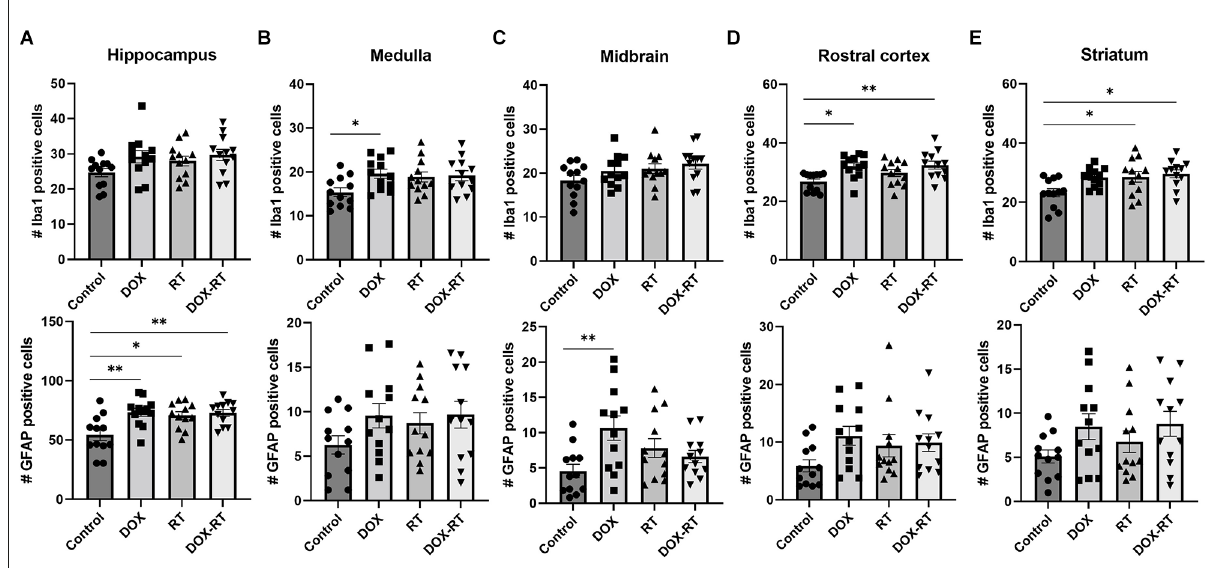
FIGURE5 Cancer therapy causes multifocal microgliosis and astrocytosis. (A–E) Bar graphs depicting Iba1+ microglia (top row) and GFAP+ astrocytes (bottom row) are shown from the hippocampus (A) , medulla (B) , midbrain (C) , rostral cortex (D) , and striatum (E) . Control mice were compared to mice treated with DOX, RT, or DOX-RT. All three treatment groups had significant increases in GFAP+ astrocytes compared to control mice in the hippocampus (A) . Mice treated with DOX had more Iba1+ microglia compared to control mice in the medulla (B) and more GFAP+ astrocytes in the midbrain (C) . Mice treated with DOX or DOX-RT mice had significantly more Iba1+ microglia compared to control mice in the rostral cortex (D) . Mice treated with RT or DOX-RT mice had significantly more Iba1+ microglia compared to control mice in the striatum (E) . Data represent the mean and SEM evaluated from four to five consecutive images per mouse ( n = 12 per group). DOX, doxorubicin group; RT, hindlimb radiation group; DOX-RT, doxorubicin and hindlimb radiation group. One asterisk ( ∗ ) representing p -value < 0.05 and two asterisks ( ∗∗ ) representing p -value <